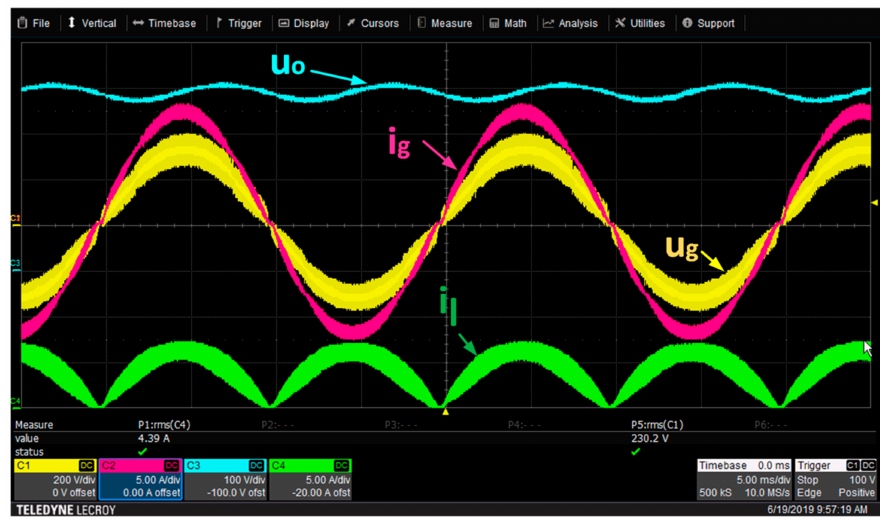
Figure 14. Measured waveforms of two units interleaved using parameters ( f sw = 20 kHz) and a phase shift of 180 ◦ given in Table 5.